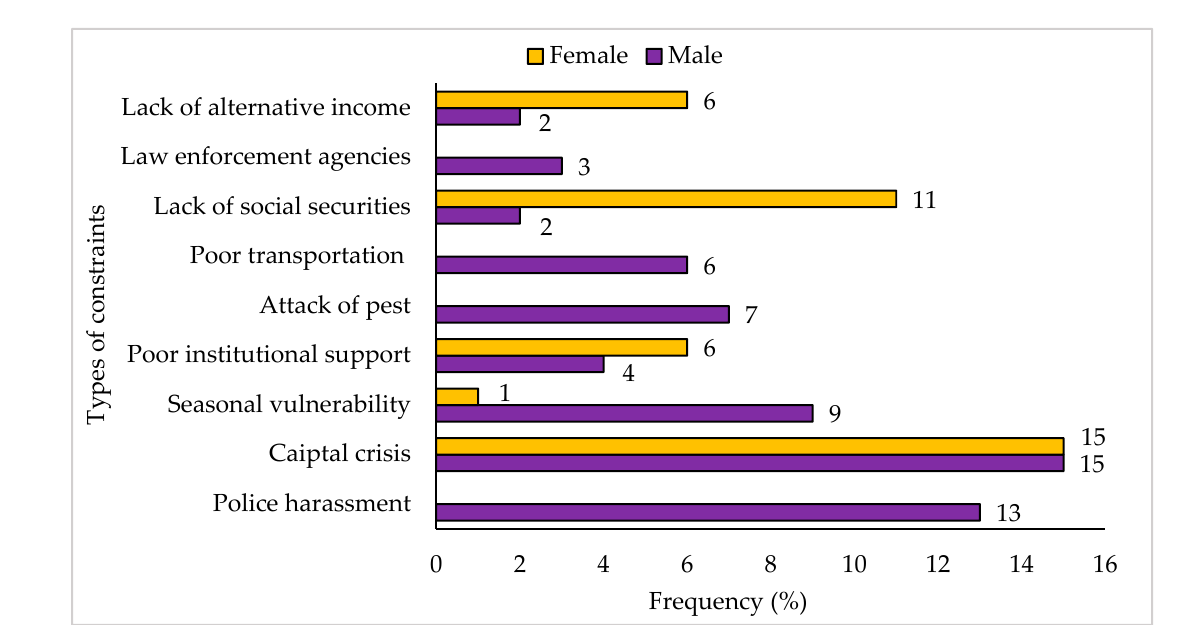
Figure 9. Significant constraints to diversified livelihoods faced by male and female respondents of the community.